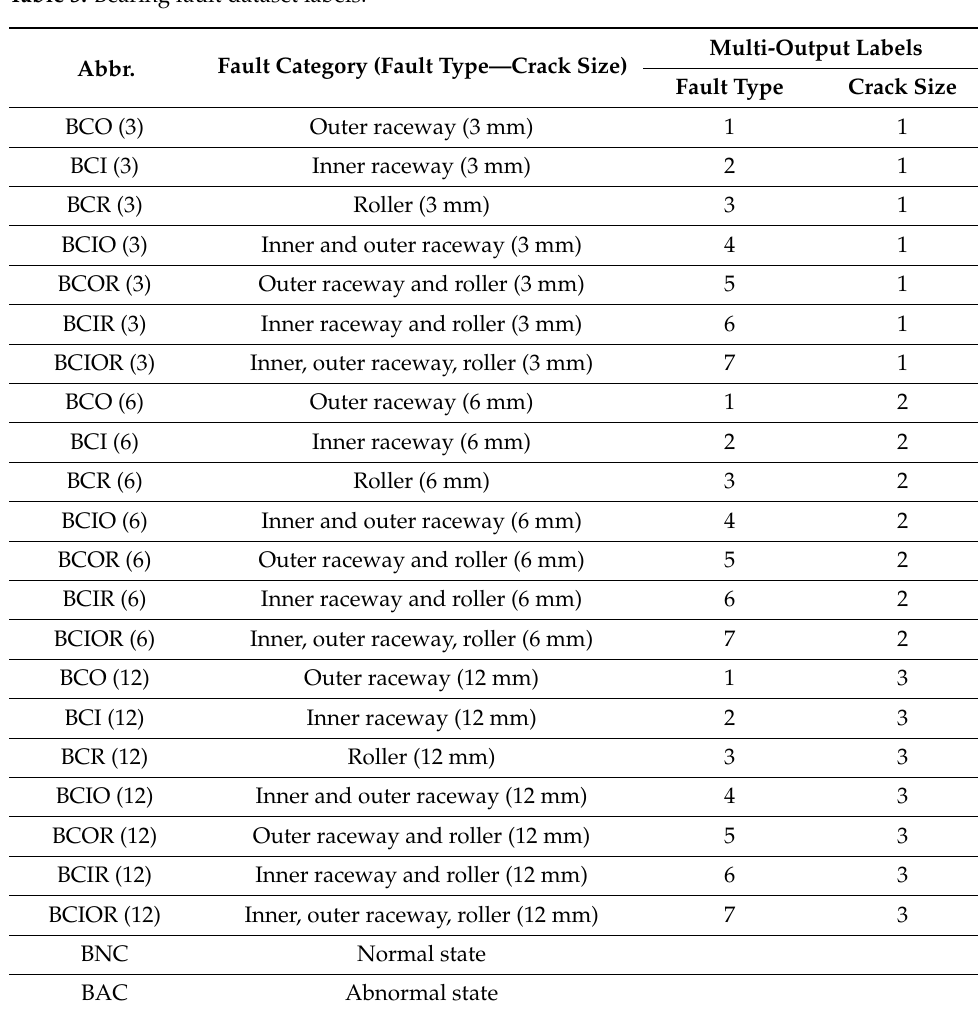
Table 3. Bearing fault dataset